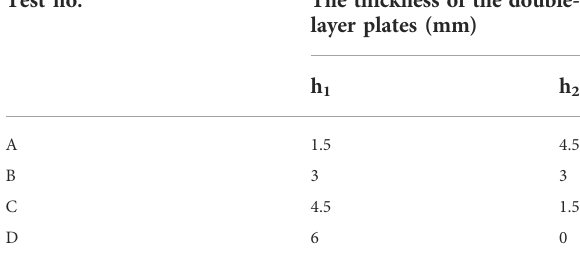
TABLE 6 Double-layer plates arrangement of unequal thickness. Test